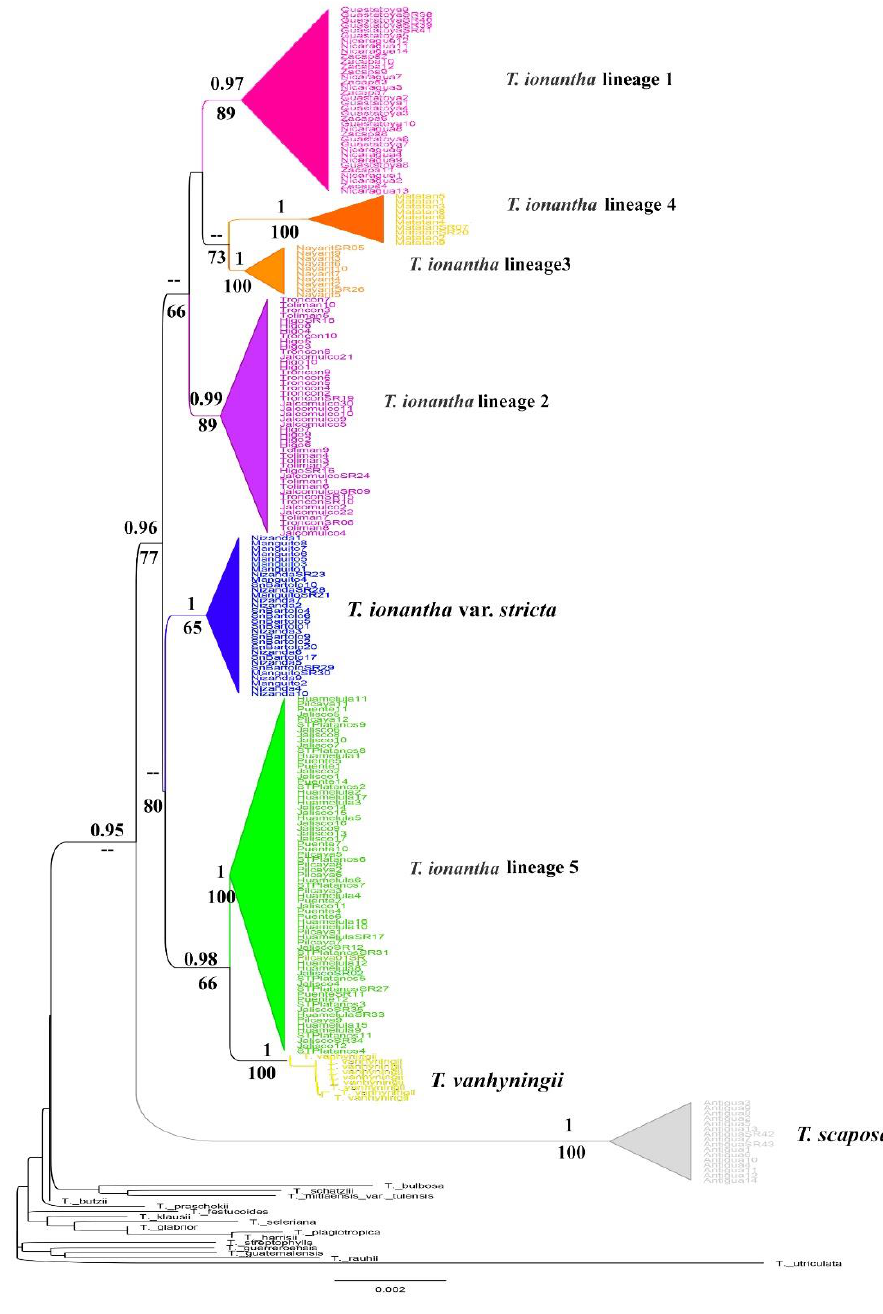
Figure 2. Phylogenetic tree estimated with Bayesian Inference using PHYC ; PPB values ≥ 0.95 on the branches; Bootstrap values ≥ 50 below the branches. The collapsed and colored clades represent each of the eight lineages within the T. ionantha complex. Uncolored branch terminals represent outgroup species.